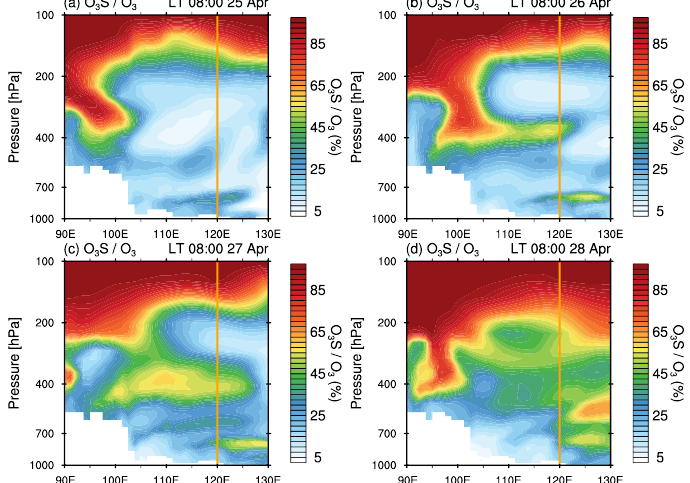
Figure 9. Longitude-height cross sections of O 3 S/O 3 ratio at 30 ◦ N from CAM-Chem simulation for the period 25–28 April 2018. ( a ) 25 April, ( b ) 26 April, ( c ) 27 April and ( d ) 28 April 2018. The vertical line indicates the longitude (120 ◦ E) of the area of